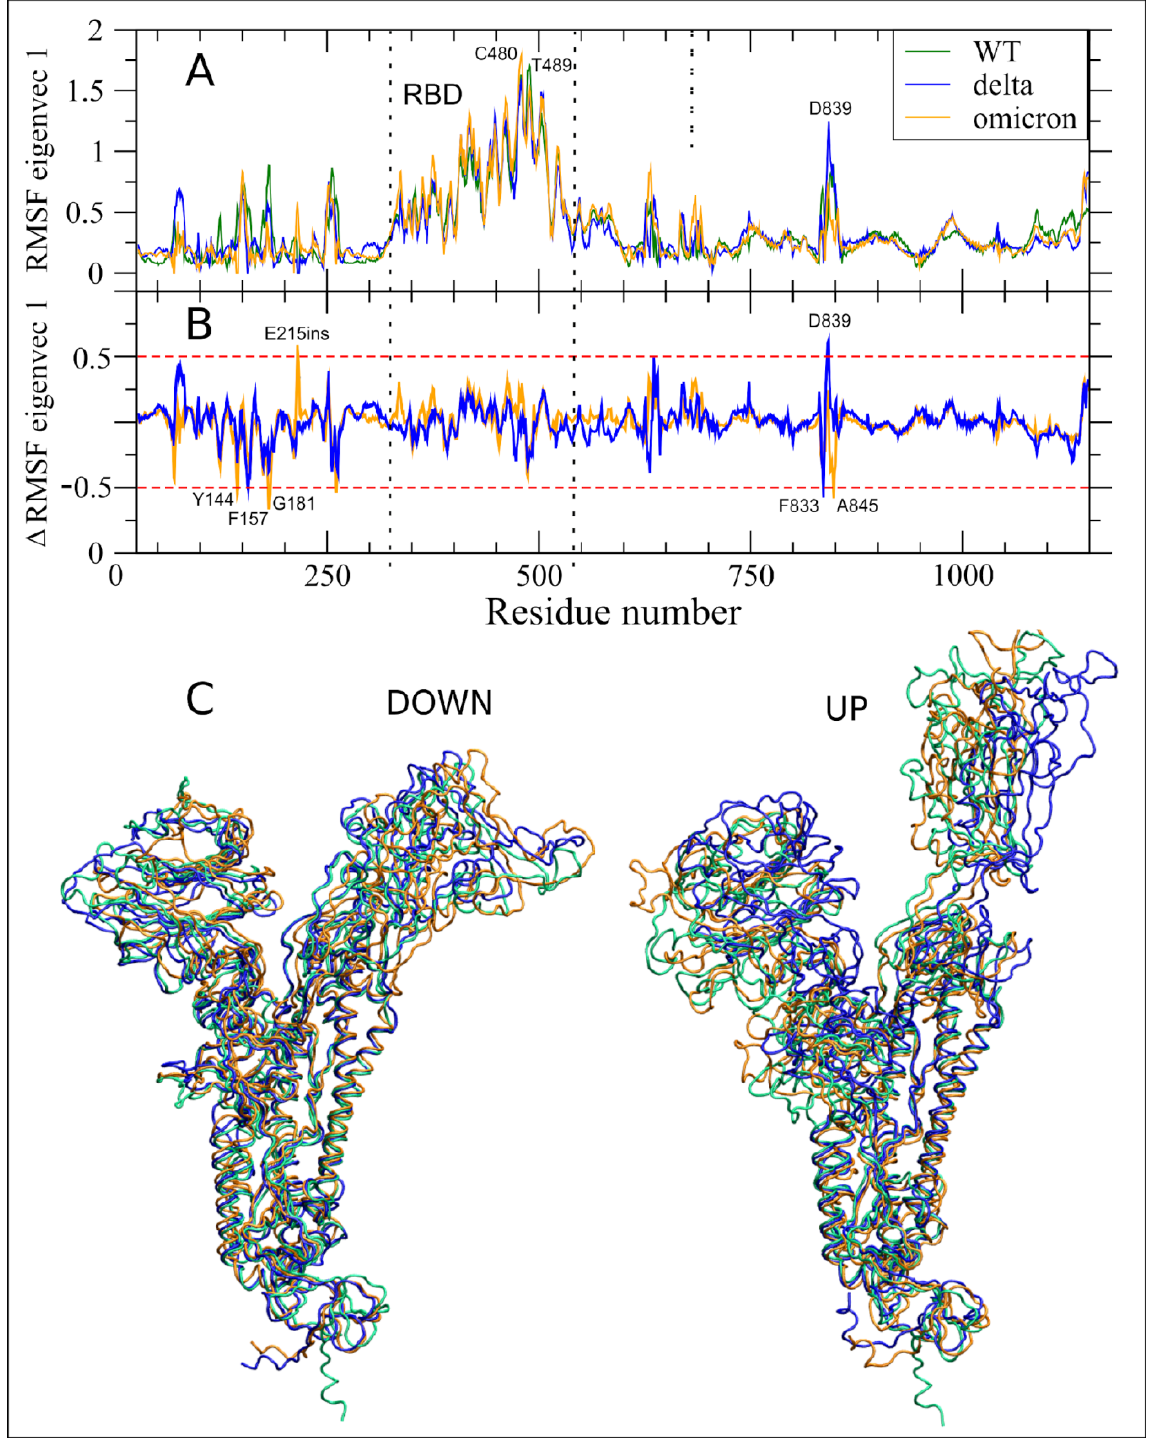
Figure 4. Essential Dynamics V1 analyses. ( A ) RMSF of the S protein filtered trajectory along V1 for WT, Delta, and Omicron are reported in dark green, blue, and orange colors, respectively. Residues corresponding to fluctuation peaks along V1 are indicated. ( B ) Difference between filtered RMSF along V1 between Delta and Omicron as compared to WT are reported in blue and orange colors, respectively. Residues out of the ±0.5 nm threshold (dashed red lines) are indicated. ( C ) Extreme projections of the monomers in down and up conformations along V1 for WT, Delta and Omicron MD trajectories are in green, blue, and orange colors, respectively.